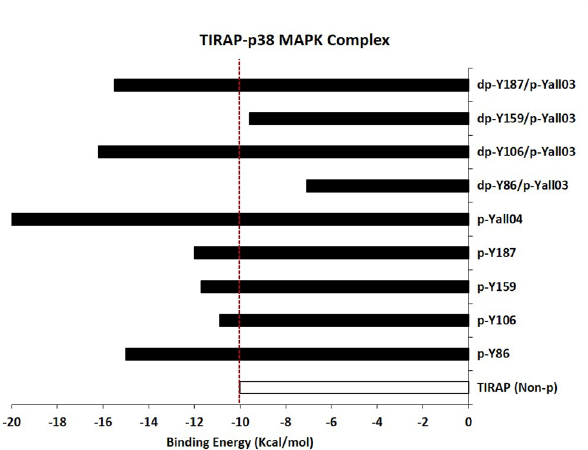
Figure 4. The molecular docking complex of p38 MAPK and conditionally phosphorylated tyrosine (pY) of TIRAP TIR domain from HADDOCK 2.4. The complex of non-phosphorylated and all four-tyrosine site phosphorylated TIRAP structure (red) and p38 MAPK (light blue) ( A ) and ( B ) are represented for a comparative purpose with a docking complex of p38 MAPK (light blue) and tyrosine-phosphorylated TIRAP (red) with de-phosphorylated (dp) tyrosine dpY86pYall03 (dark blue) ( C ), dpY106pYall03 (dark blue) ( D ), dpY159pYall03 (dark blue) ( E ) and dpY187pYall03 (dark blue) ( F ), respectively. The complexes are the top pose result of HADDOCK 2.4 docking and images are prepared in Discovery studio Visualizer. The tyrosine residues of TIRAP (dark blue) and p38 MAPK (cyan) are represented in a ball and stick and cpk (Corey-Pauling-Koltun) format. The images were prepared using a Discovery studio Visualizer v21.1.0.20298. The interacting interface residues between both proteins were analyzed with the 3 Å region in the Chimera v1.13.1 tool (Supplementary Table S1).